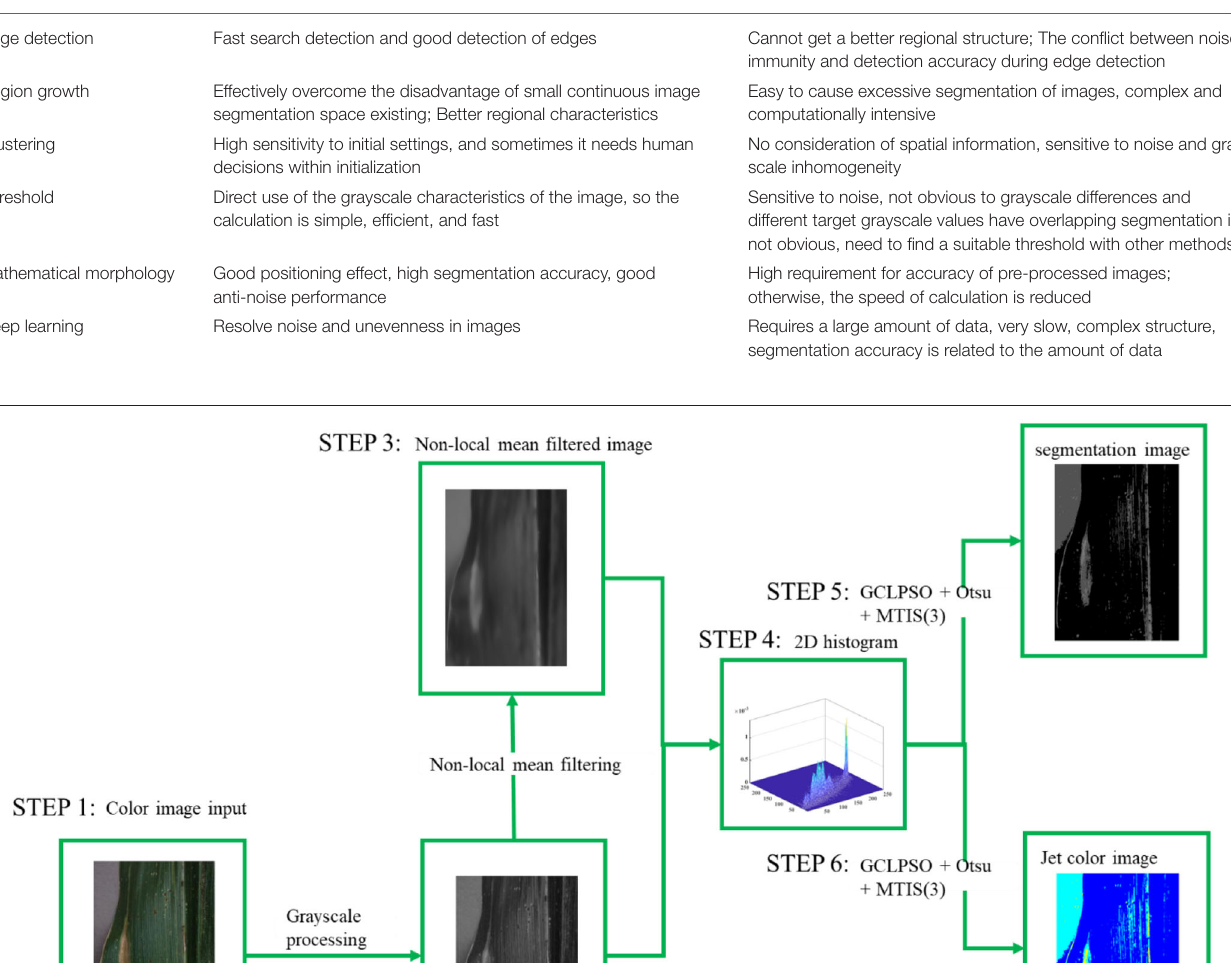
2020), and Slime mould algorithm (SMA) (Abbassi et al., 2019), respectively. The segmentation experiments with